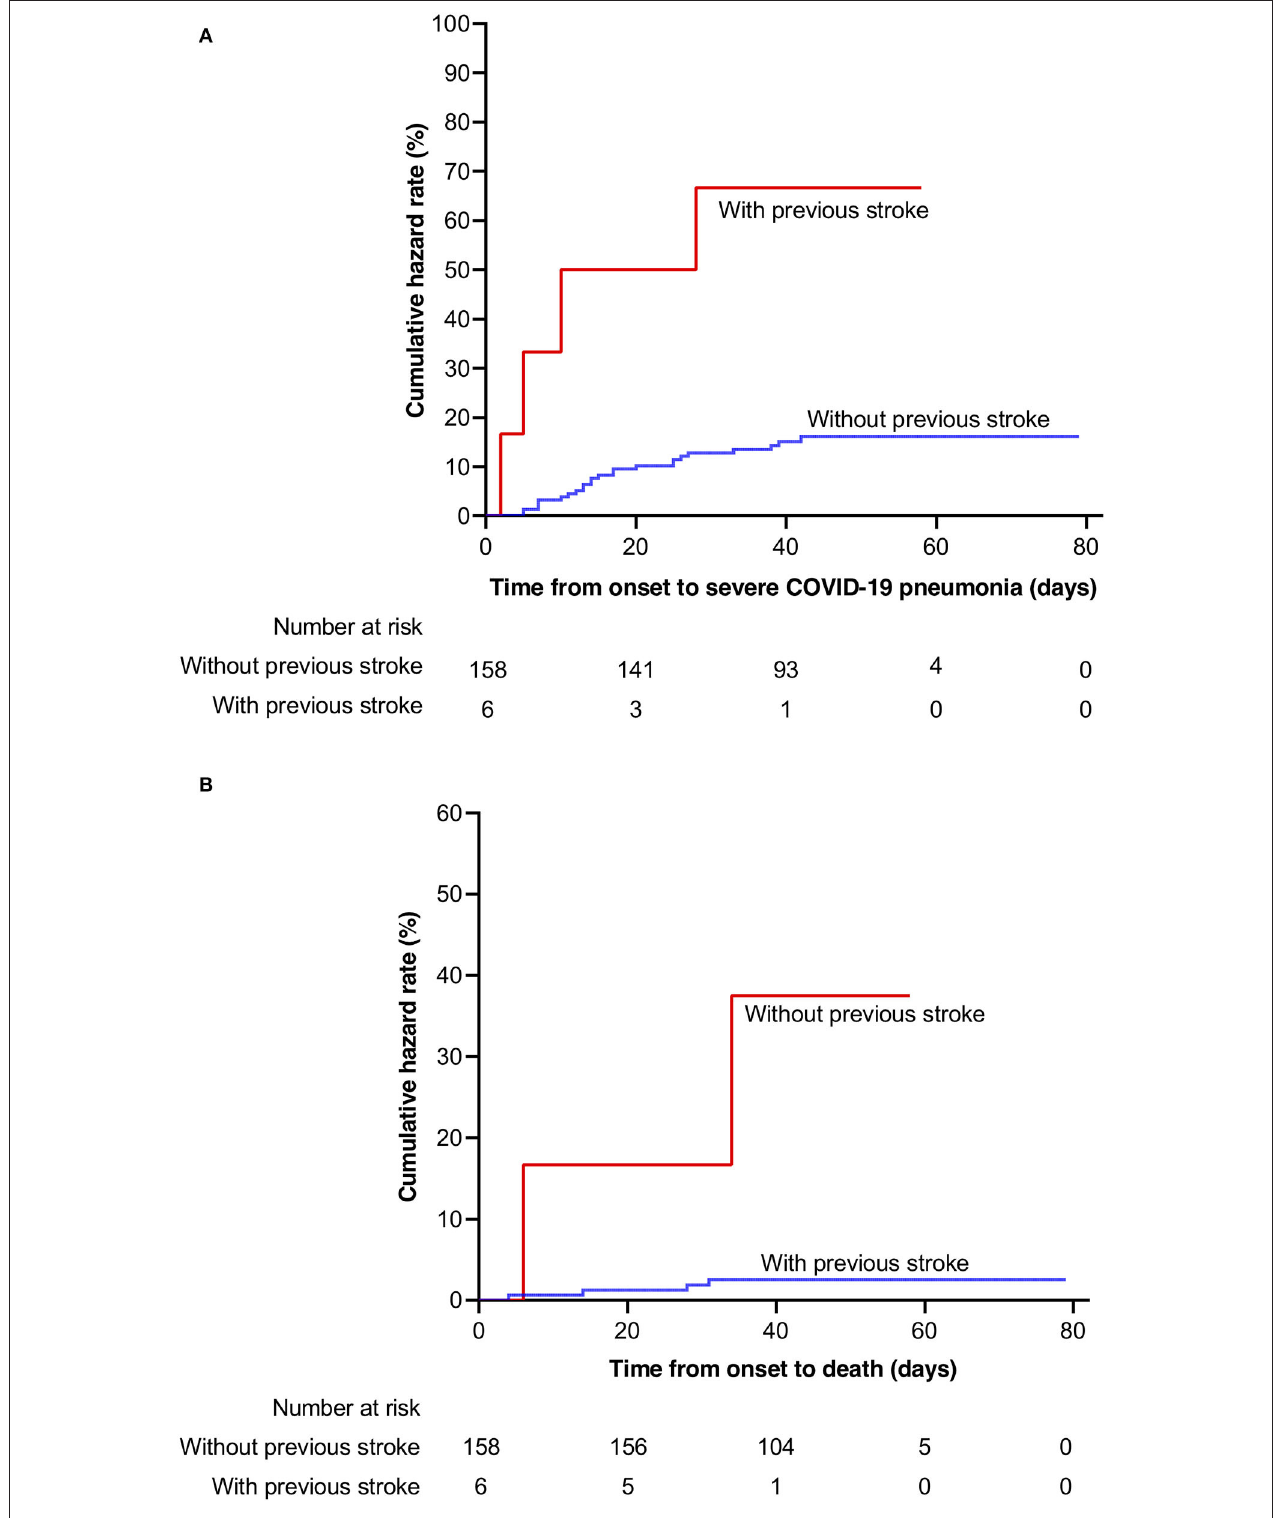
FIGURE 1 | Kaplan–Meier probabilities in patients with and without previous stroke. (A) severe COVID-19; (B) mortality. COVID-19, coronavirus disease 2019.